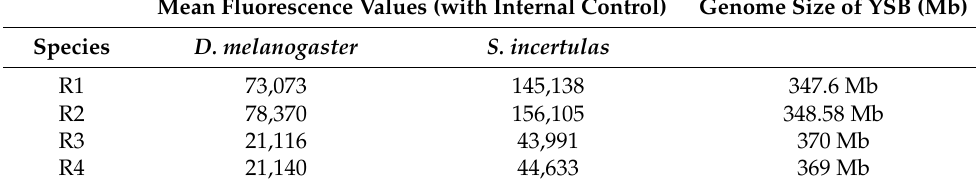
Table 1. Mean average value detected in flow cytometry. Mean Fluorescence Values (with Internal Control) Genome Size of YSB (Mb)